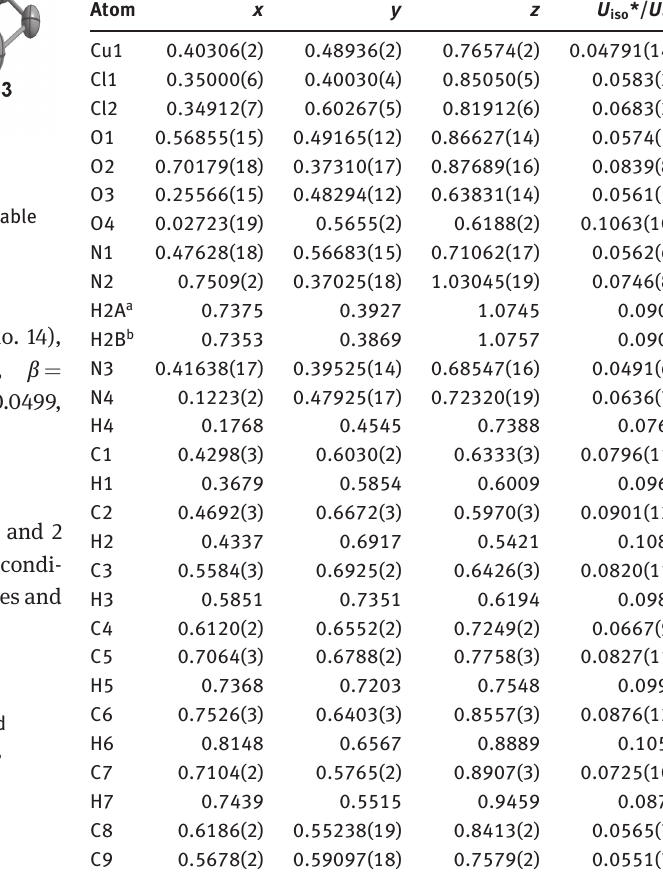
Table 2: Fractional atomic coordinates and isotropic or equivalent isotropic displacement parameters (Å 2